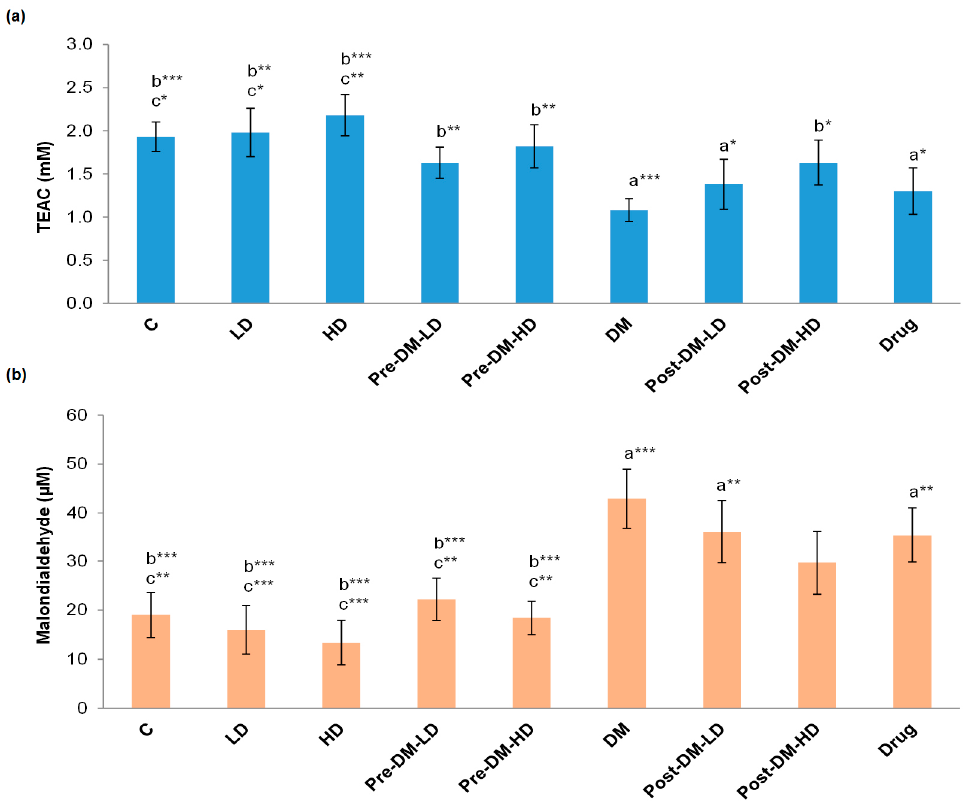
Figure 2. ( a ) Effect of GBRE supplement on the total antioxidant capacity of the experimental rats. The values are represented as Trolox equivalent of antioxidant capacity (TEAC); ( b ) MDA values of different rat groups. The MDA values are indirectly proportional to the lipid peroxidation inhibition ability. All the values are represented as mean ± SD of three determinations. C: Control, LD: Low dose of GBRE to naïve rat, HD: High dose of GBRE to naïve rat, DM: Diabetes Mellitus induced rat, Pre-DM-LD: Low dose of GBRE to naïve rat and induced DM, Pre-DM-HD: High dose of GBRE to naïve rat and induced DM; Post-DM-LD: Low dose of GBRE to DM rat, Post-DM-HD: High dose of GBRE to DM rat. The significant difference between the groups (a = when compared with control group; b = when compared with DM group; c = when compared with the drug group) were represented as * ( p < 0.05), ** ( p < 0.01), and *** ( p < 0.001).